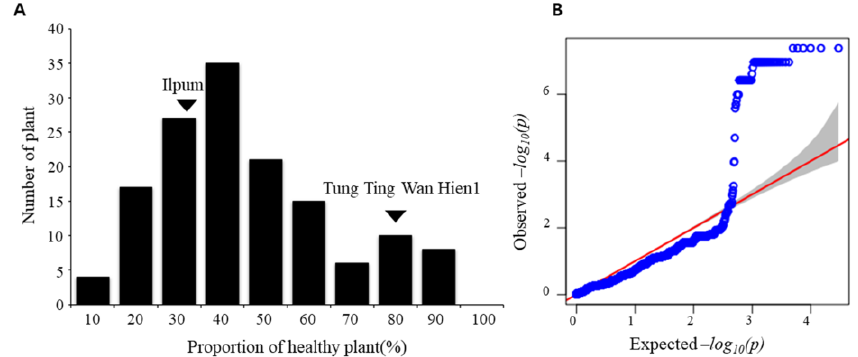
Figure 3. Frequency distributionof the proportion of healthy plants ( n = 143) in BC 1 F 8 . Near Isogenic Lines. ( A ) frequency distribution and ( B ) quantile-quantile (Q-Q)